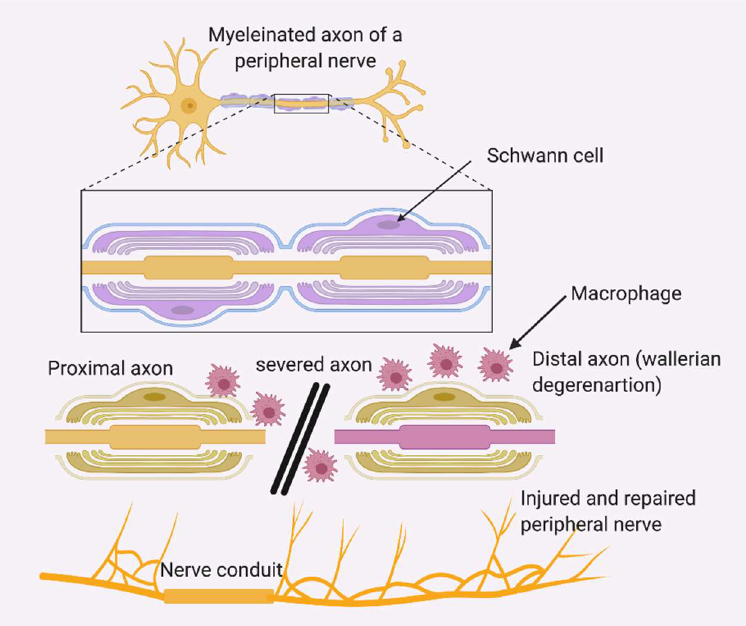
Figure 1. Structure of a peripheral nerve axon. In severe injuries, the axons break apart, and macrophages will clear off the injury site through phagocytosis. A peripheral nerve conduit consisting of supporting cells (Schwann cells, neural progenitor cells, neurons or induced pluripotent stem cells (iPSCs)), growth factors and biocompatible scaffold materials will aid in faster healing and rehabilitation. A nerve conduit used to fill the gap of the injured nerve is an artificially made nerve tissue mimic or artificial nerve graft, which guide axonal regrowth to facilitate regeneration of damaged nerves.